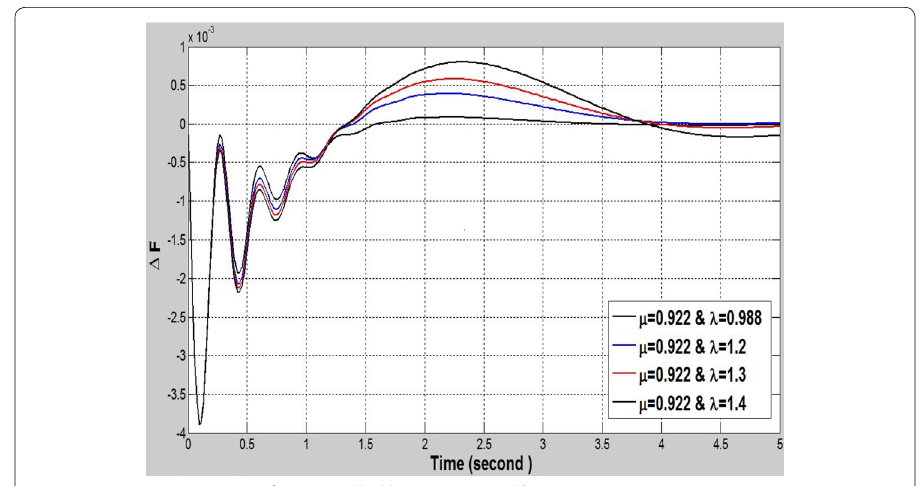
Fig. 13 Dynamic responses of ∆F controlled by TBFOPID and λ > 1